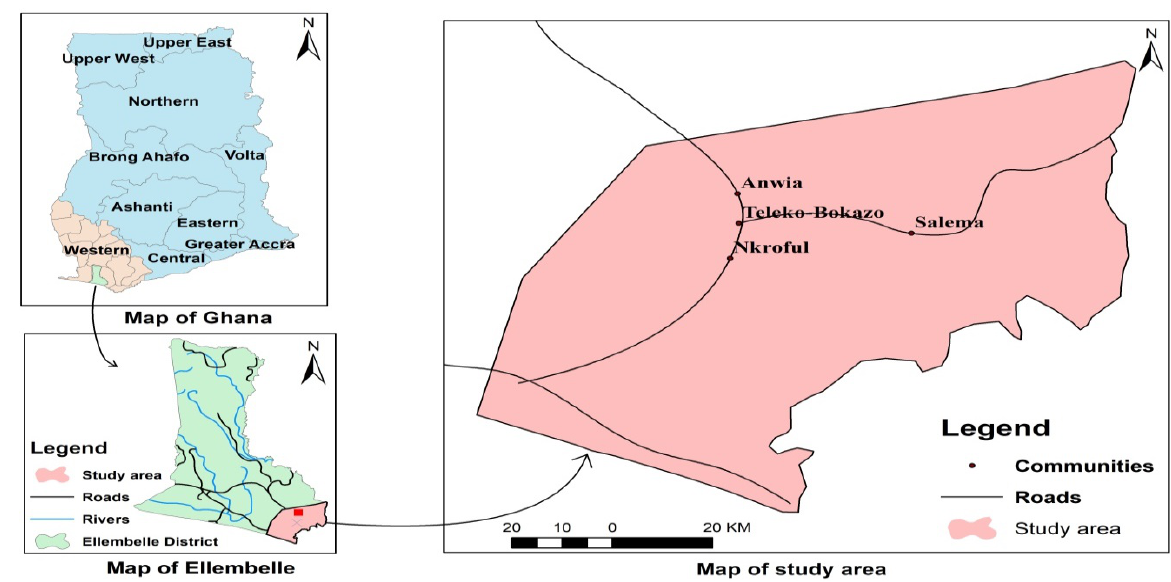
Figure 2. Map of Ellembelle District containing study communities (2020).